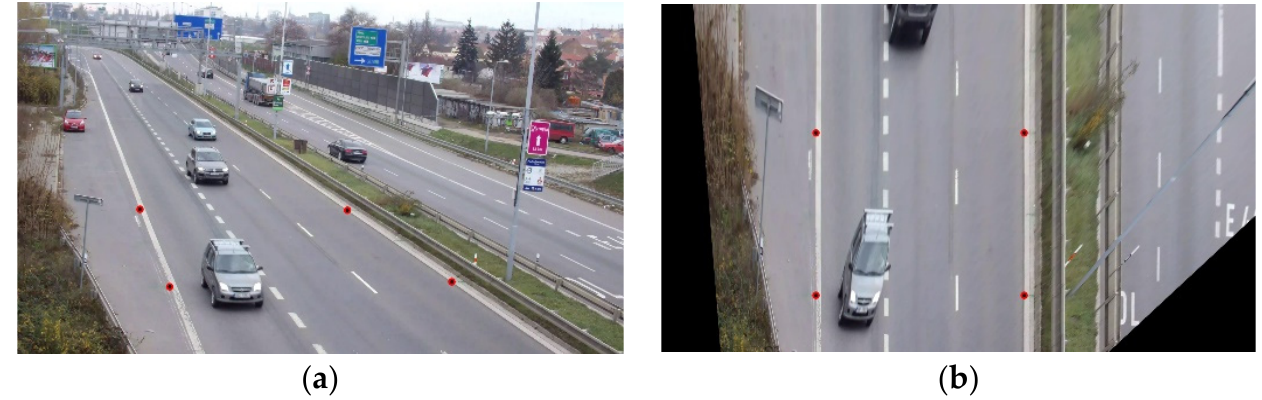
Figure 3. Coordinates transform: ( a ) an input image with the 4 points marked; ( b ) the result of applying the transformation to all the pixels of the image. Note that the road has lost its perspective, and it looks like it is seen from above, while the cars are deformed because they do not belong to the characterised road plane.